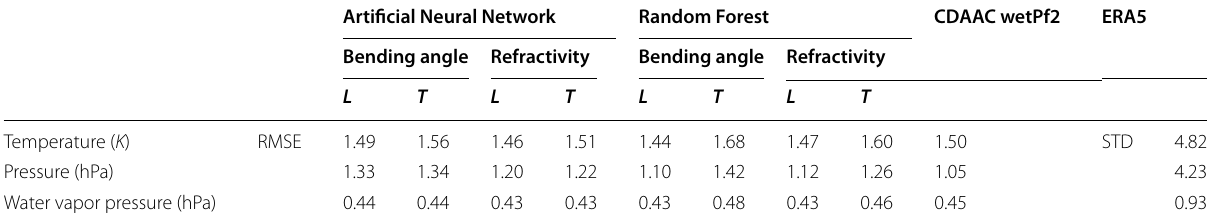
Table 1 Fitting results obtained on the training and test data sets